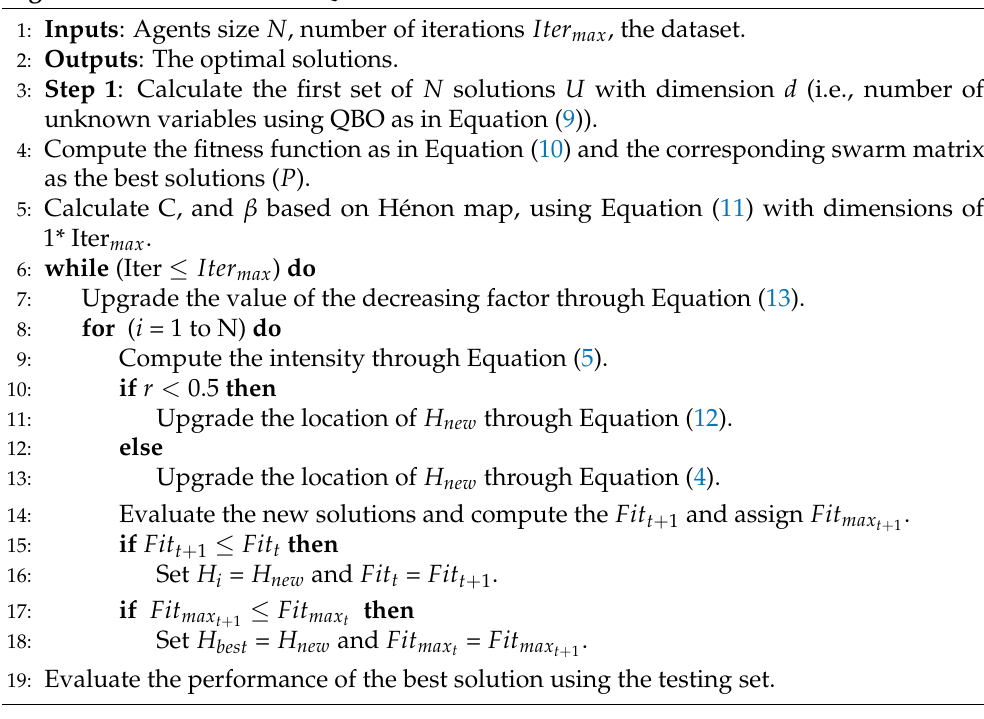
Algorithm 2 Pseudo code of